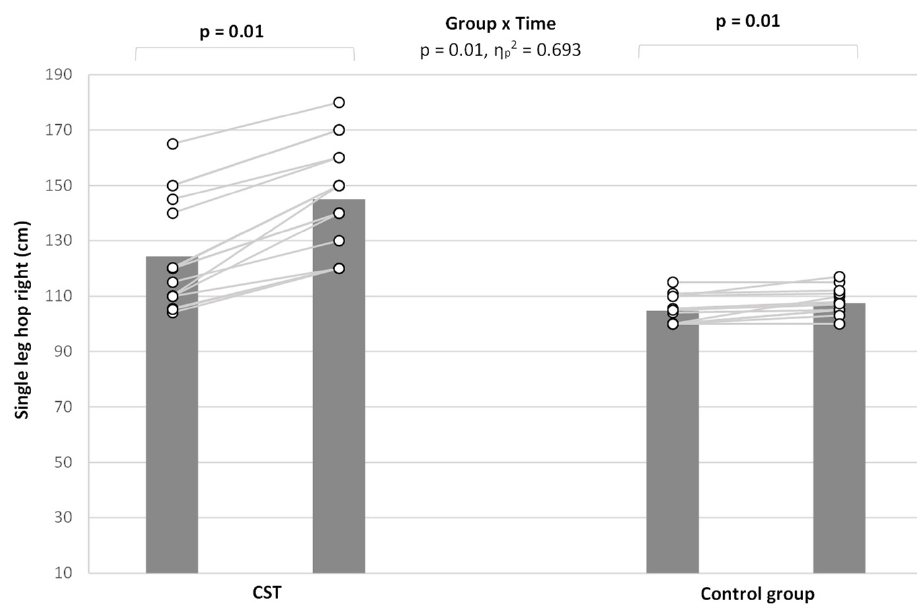
Figure 2. Participants performance before and after intervention period of single-leg hop right performance by the two groups. CST: contrast strength training group.